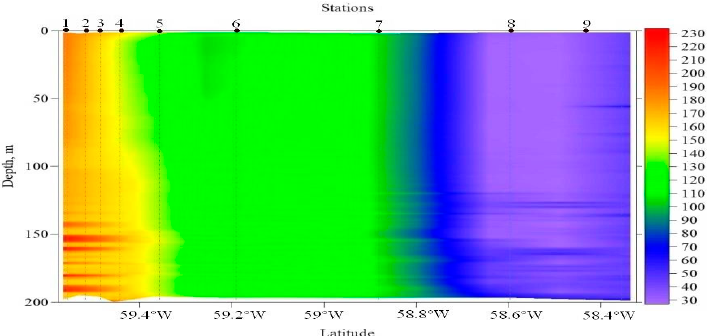
Figure 12. Vertical section of bioluminescence (10 − 12 W · cm − 2 · L − 1 ) in the Bransfield Strait (Figure 5). At stations 2, 3, 4, 5, 6, and 7, the average level of bioluminescence varied from 88 × 10 − 12 W · cm − 2 · L − 1 to 166 × 10 − 12 W · cm − 2 · L − 1 , the structure being evenly distributed across depth with slight peaks. At central stations of the section, a high-gradient zone was formed where the water temperature varied from 1.32 ◦ C to 1.76 ◦ C. The lowest level of the bio- luminescent signal, with values of 18.69 × 10 − 12 W · cm − 2 · L − 1 and 17.42 × 10 − 12 W · cm − 2 · L −